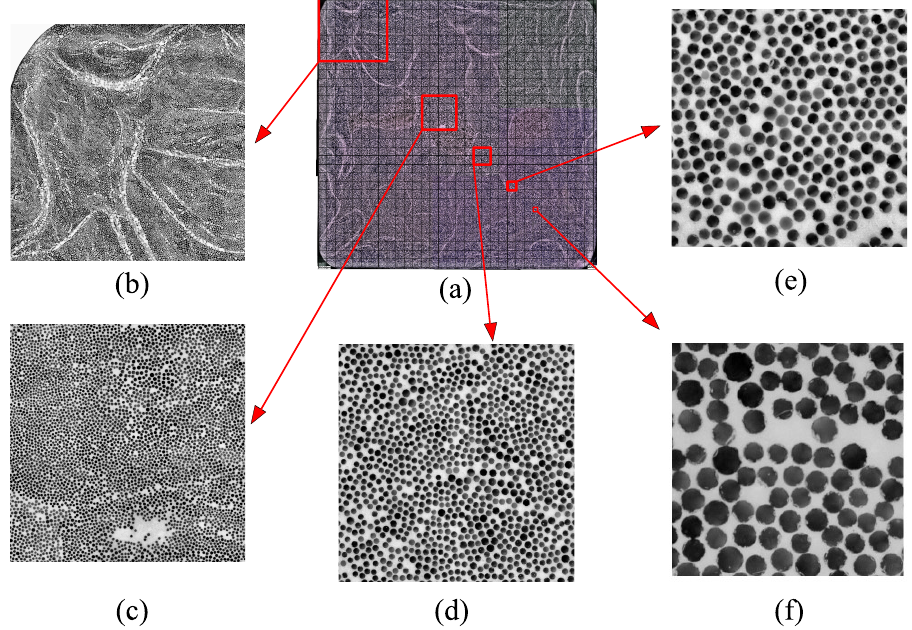
Figure 2. One of the analyzed cross sections ( a ) with examples of different RVE sizes for 4 × 4 patches (Case A), ( b ) 8 × 8 patches (Case B), ( c ) 16 × 16 patches (Case C), ( d ) 32 × 32 patches (Case D) ( e ) and 64 × 64 patches (Case E) ( f ). The grid used in ( a ) reflects 32 × 32 patches. Table 1. The used labels, the corresponding number of patches, and the RVE edge lengths.